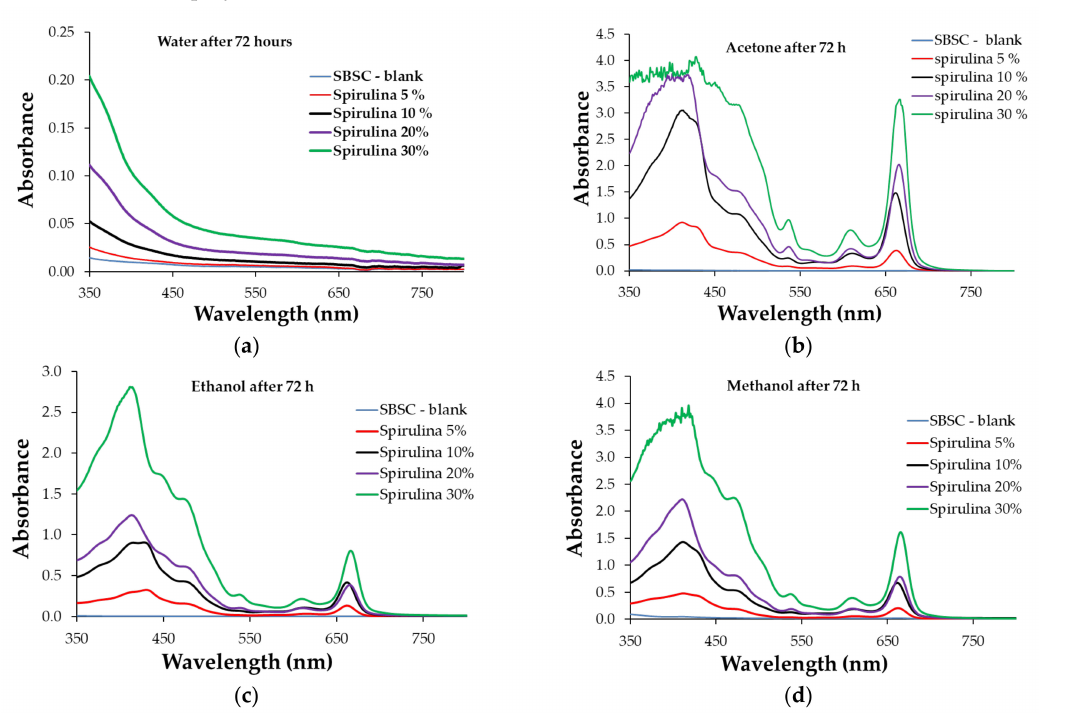
Figure 12. UV-Vis spectra for extraction solutions after 72 h of contact with Spirulina polymer